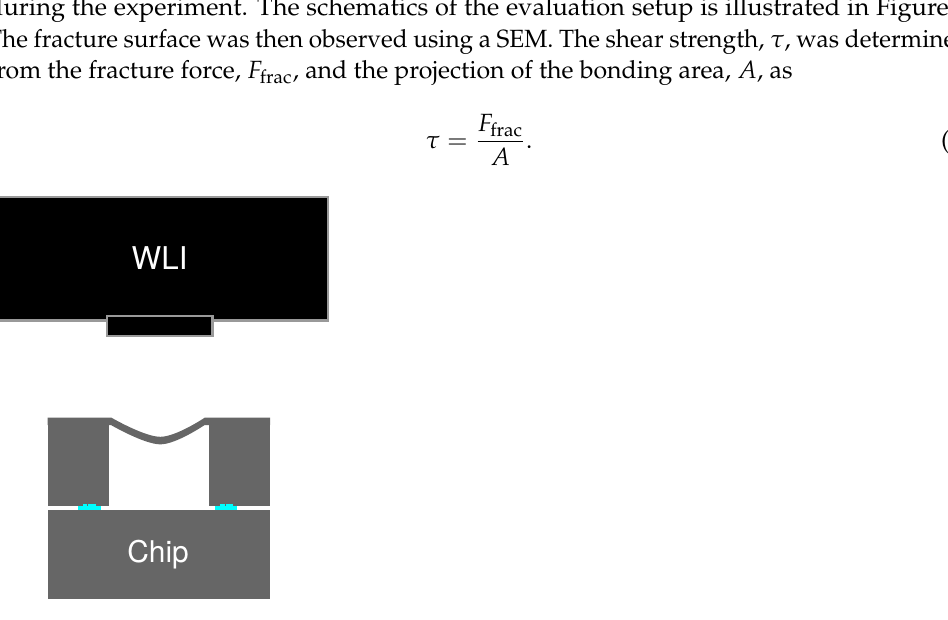
Figure 4. Schematics of the surface topography measurement setup for sealed cavity pressure evaluation.